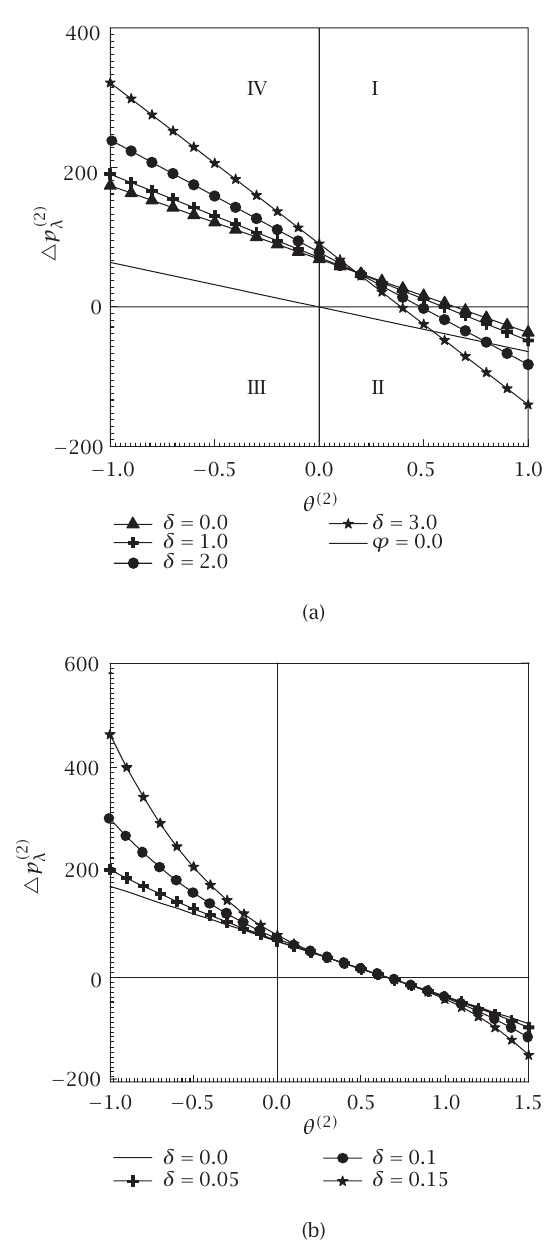
Figure 6.1 . The pressure gradient per wavelength (cid:5) p ( 2 ) dimensionless flow rate θ ( 2 ) for ϕ = 0 . 5, M = 2 . 5, K = 0 . 8, and different values of δ , at (a) Re = 0 and (b) Re = 10 ( ϕ → 0, γ → 0 Poiseuille